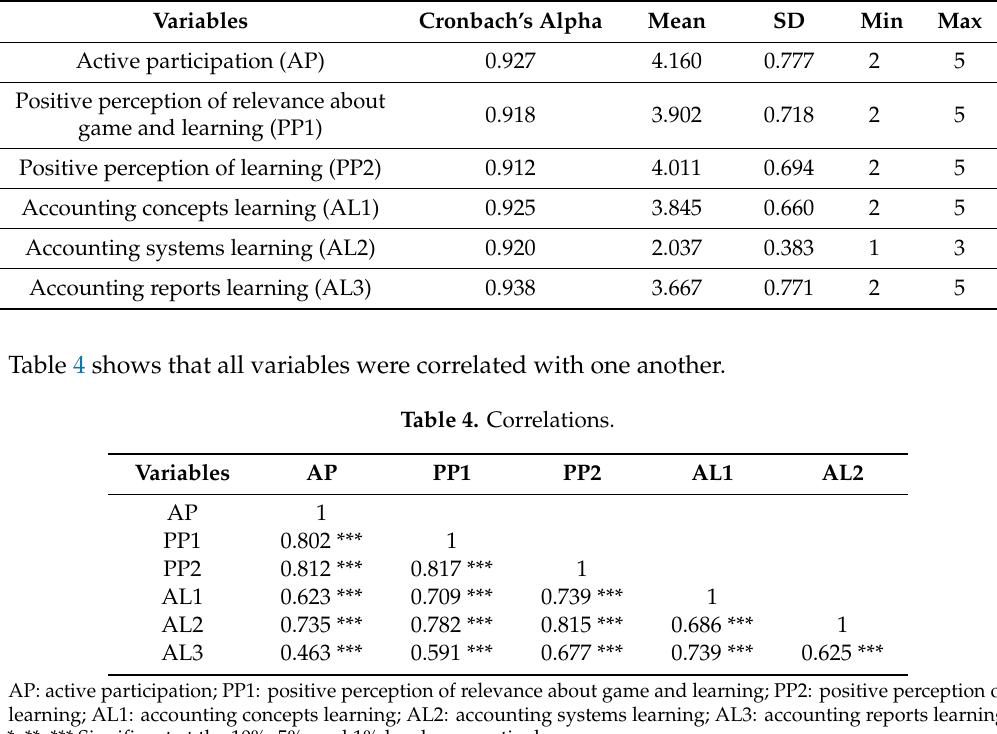
Table 3. Descriptive statistics and Cronbach’s alpha.